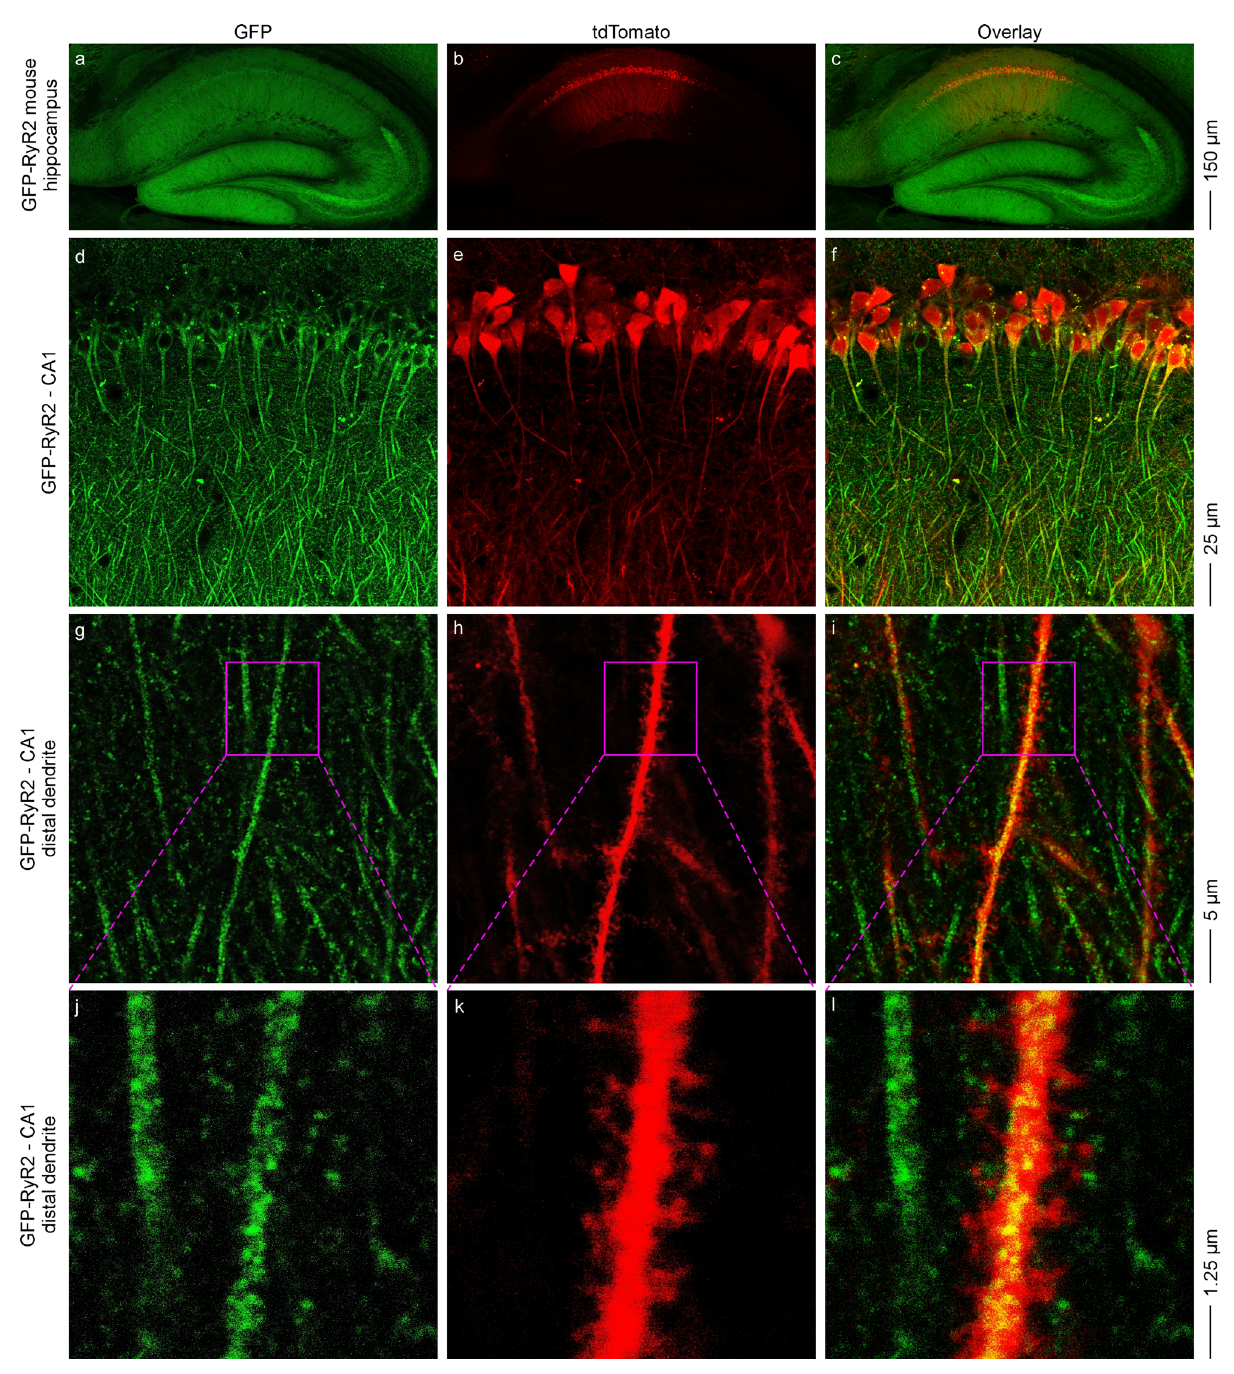
Fig. 3 Confocal imaging of live hippocampal slices from GFP-RyR2 mice with AAV9-tdTomato infected CA1 region. Representative confocal fl uorescence images of live hippocampal slices from mice expressing the GFP-tagged RyR2 with AAV9-tdTomato infected CA1 region ( n = 9 images from three brains). Images of the whole hippocampal area showing the AAV9-tdTomato infected CA1 region ( a – c ). Magni fi ed views showing the CA1 area ( d – f ), a single tdTomato- fi lled distal dendrite ( g – i ), and the dendritic spines of the tdTomato- fi lled distal dendrite ( j – l frequency of these spontaneous Ca 2 + transients in both the soma (Fig. 5a – d, i, j) and dendritic shafts (Fig. 5e – j) in RyR2 R4496C + / − mutant brain slices at rest (i.e., without KCl perfusion) was markedly increased compared to those in WT. Note that here KCl depolarization was applied to the brain slices after fi nishing recording of spontaneous Ca 2 + transients at rest to identify viable neurons. Thus, the arrhythmogenic RyR2 R4496C + / − mutation increases the occurrence of spontaneous Ca 2 + transients, which is consistent with increased neuronal excitability.